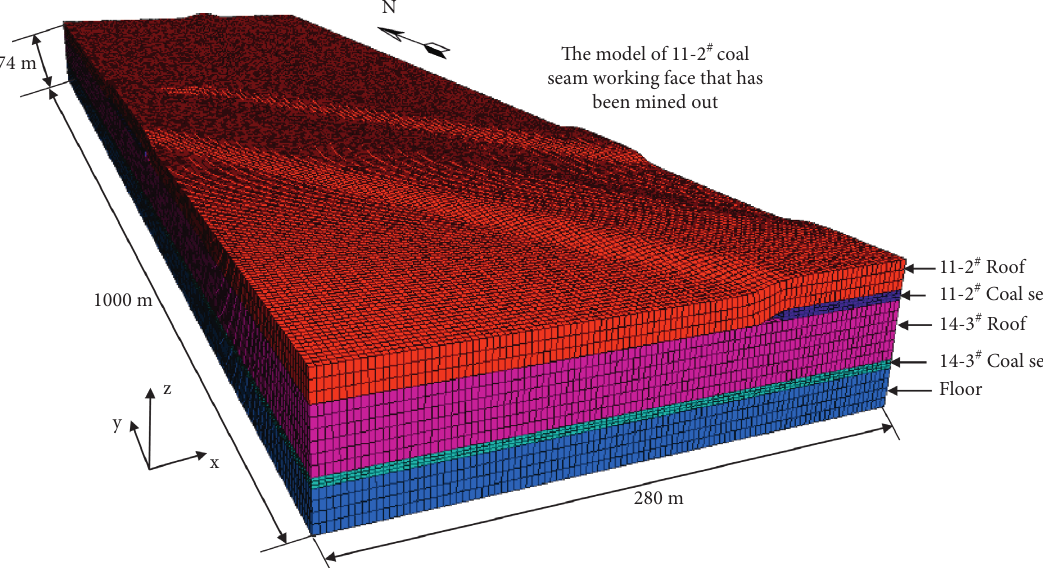
Figure. 10: Numerical simulation model.